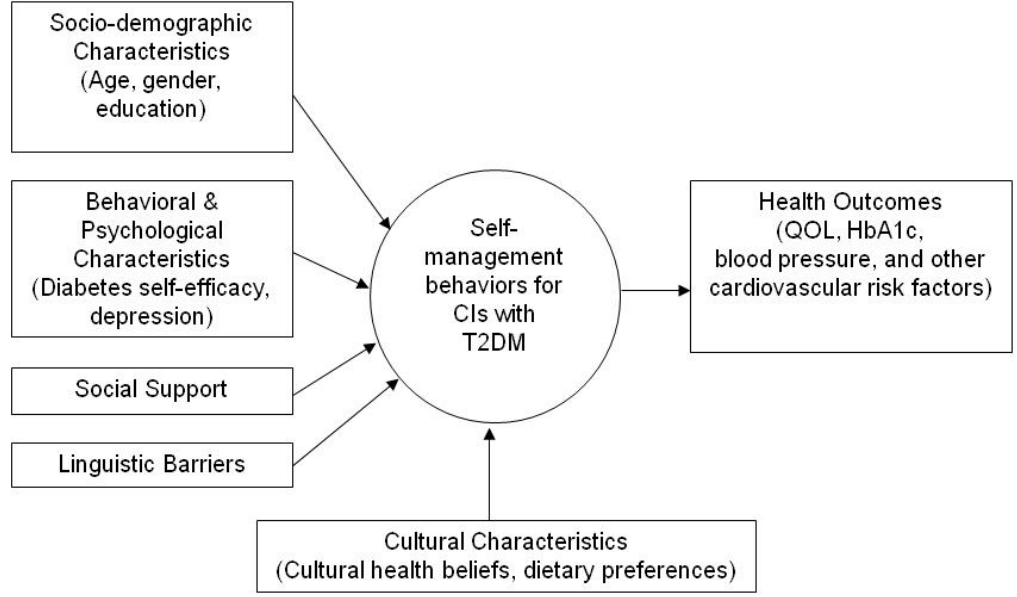
Figure 1. Towards A Conceptual Model of T2DM Self-Management in Chinese Immigrants with Type 2 Diabetes